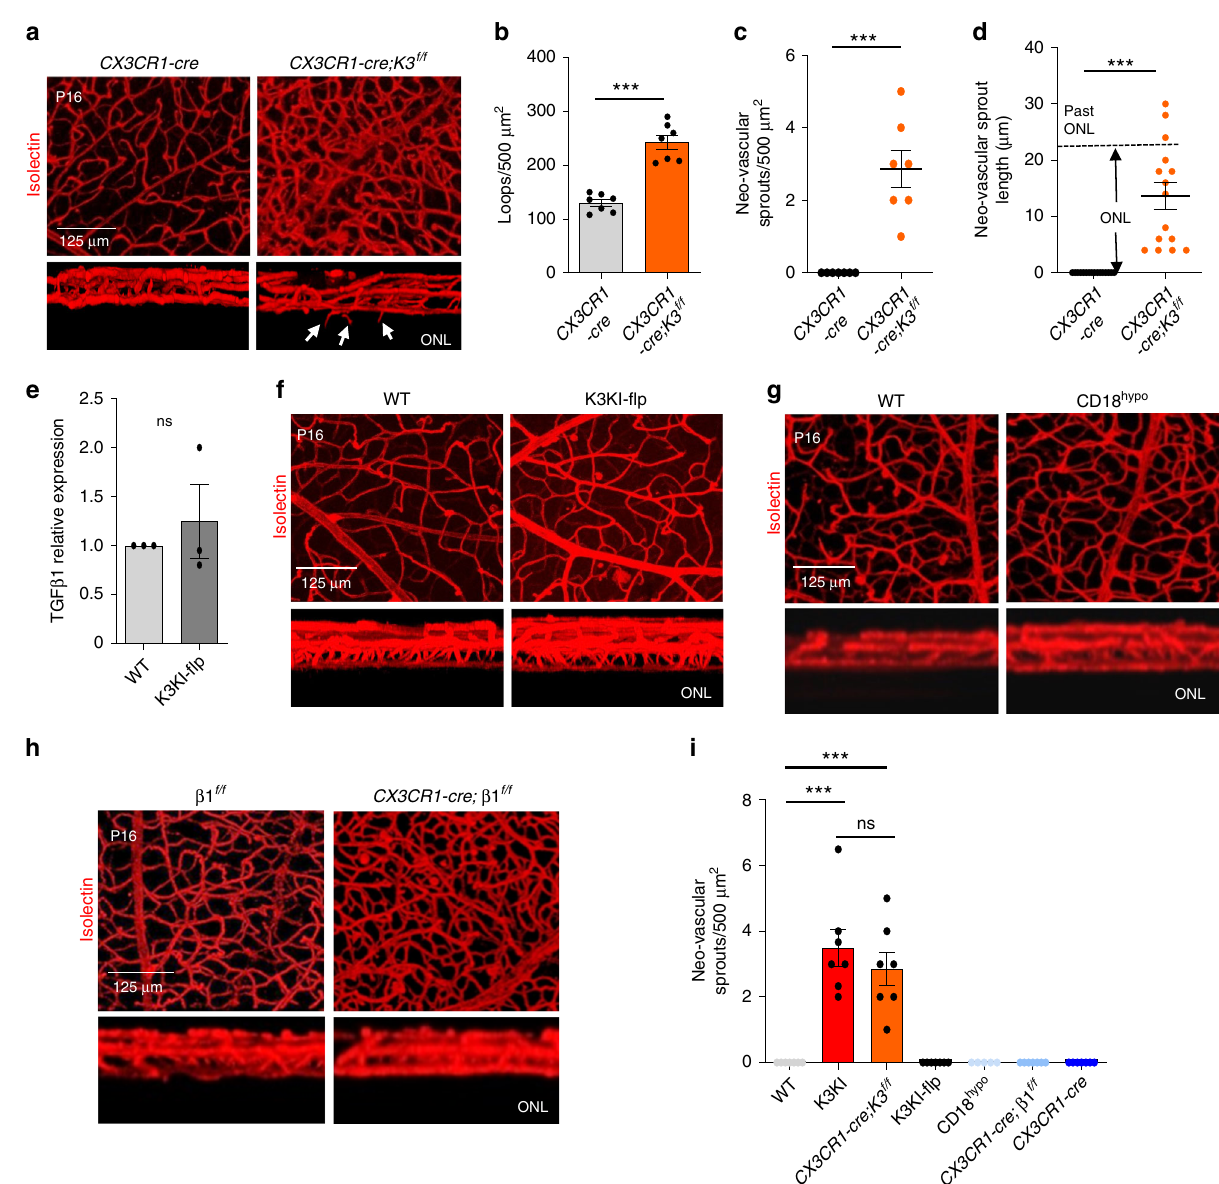
Fig. 5 Kindlin3 levels are crucial for microglial function and normal vascularization. a Excision of Kindlin3 in microglia is suf fi cient to induce vascular overgrowth. 3D-reconstituted P16 vasculature plexus from WT and microglia-speci fi c conditional Kindlin3 knockout mouse ( CX3CR1-cre;K3 f/f ) retinas. Superimposed and cross-sectional views of the vascular layers are shown. The white arrowheads indicate the neovascular sprouts invading the ONL. Representative of three mice per genotype. b – d Quanti fi cation of deep vascular loop density (two-tailed t -test; P < 0.0001 (***); N = 7 mice), the average number of neovascular sprouts from the deep plexus per retina (two-tailed t -test; P < 0.0001 (***); N = 7 mice), and their respective lengths invading into the ONL (two-tailed; P < 0.0001 (***); N = 15 neovascular sprouts). e Mean relative expression of TGF β 1 mRNA as assessed by QPCR in K3KI- fl p and WT primary microglial cells in culture (two-tailed paired t -test; P = 0.5440 (ns); N = 3 experiments). f A 3D reconstruction of retinal vascular plexus from whole-mount retinas of WT and K3KI- fl p P16 mice stained with isolectin. A representative of four (K3KI- fl p) and seven (WT) mice are shown. The top panel is a superimposed view of all three layers of vasculature and the bottom panel is a lateral view of the vascular plexus. g Retinal vascular plexus from whole-mount isolectin-stained retinas from control (WT) and β 2 knockout (CD18 hypo ) P16 mice. A representative of three (CD18 hypo ) and seven (WT) mice is shown. h 3D reconstruction of retinal vascular plexus from whole-mount retinas from β 1 knockout ( CX3CR1-cre; β 1 f/f ) and control ( β 1 f/f ) P16 mice stained with isolectin. A representative of four ( β 1 f/f ) and seven ( CX3CR1-cre; β 1 f/f ) mice are shown. i Quanti fi cation of the number of neovascular sprouts of the deep vascular plexus into the ONL of fl at-mounted P16 retinas (one-way ANOVA with Tukey ’ s post hoc; P < 0.0001 (***), P = 0.9205 (ns); N = 5 mice for CX3CR1-cre; β 1 f/f and 7 mice for all other groups. All bar graphs and dot plots are represented as mean and error bars are media by centrifugation at 700 × g for 10min 23 . Microglia carrying the tamoxifen- the meninges were removed. The tissue was dissociated in cold PBS into a slurry, passed through a 70 µm sieve, and centrifuged to pellet the cells. The cell pellet was inducible CX3CR1-cre with K3 f/f gene were treated with 10nm 4- then resuspended in DMEM/F12 (with 20% FBS, 100U/ml penicillin and strep- hydroxytamoxifen (4-HT) by addition to the medium every 48h for ef fi cient tomycin, 0.25µg/ml amphotericin B and supplementation of non-essential amino excision of the Kindlin3 gene. For microglia activation assay, microglia were plated on coverslips and treated with 20mg/ml CS and 10ng/ml C5a or vehicle alone (control) for 6h.